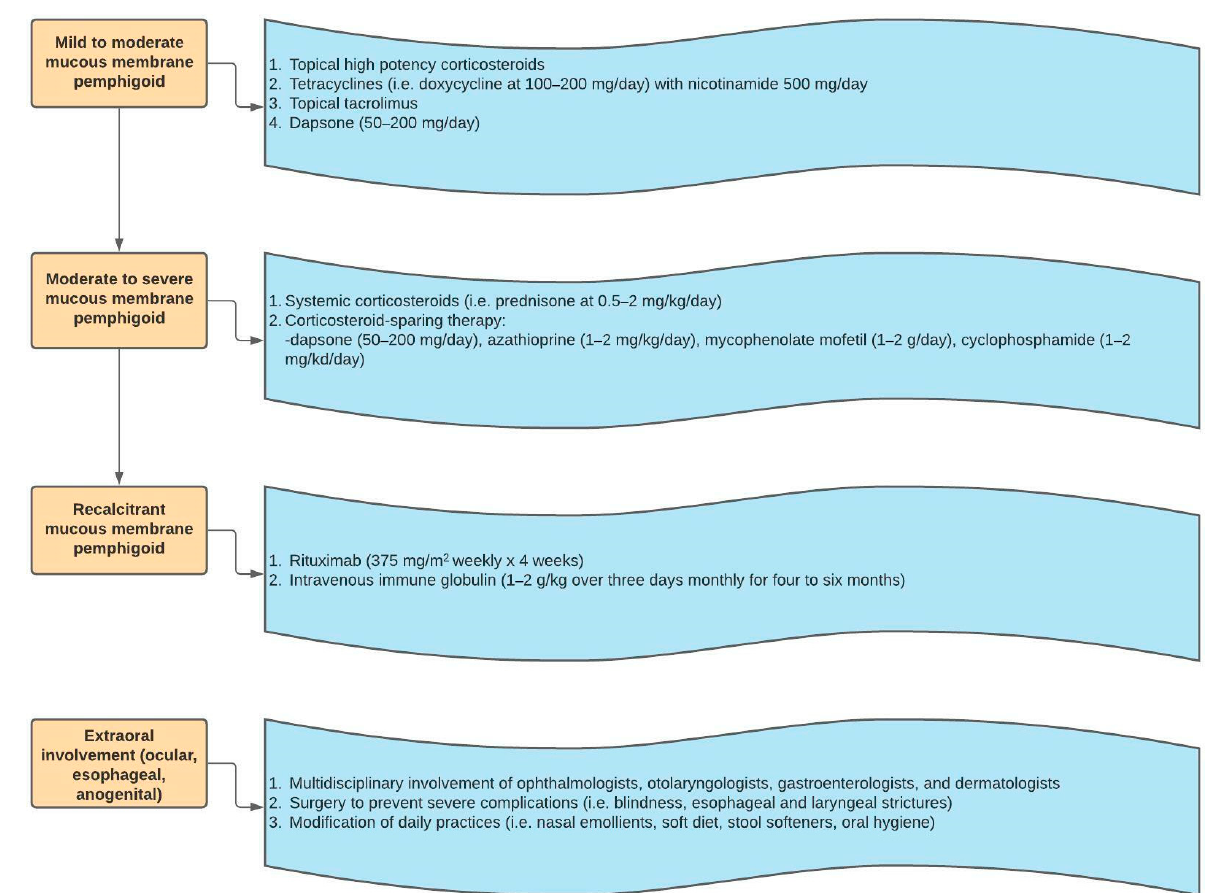
Figure 6. Mucous membrane pemphigoid treatment algorithm.